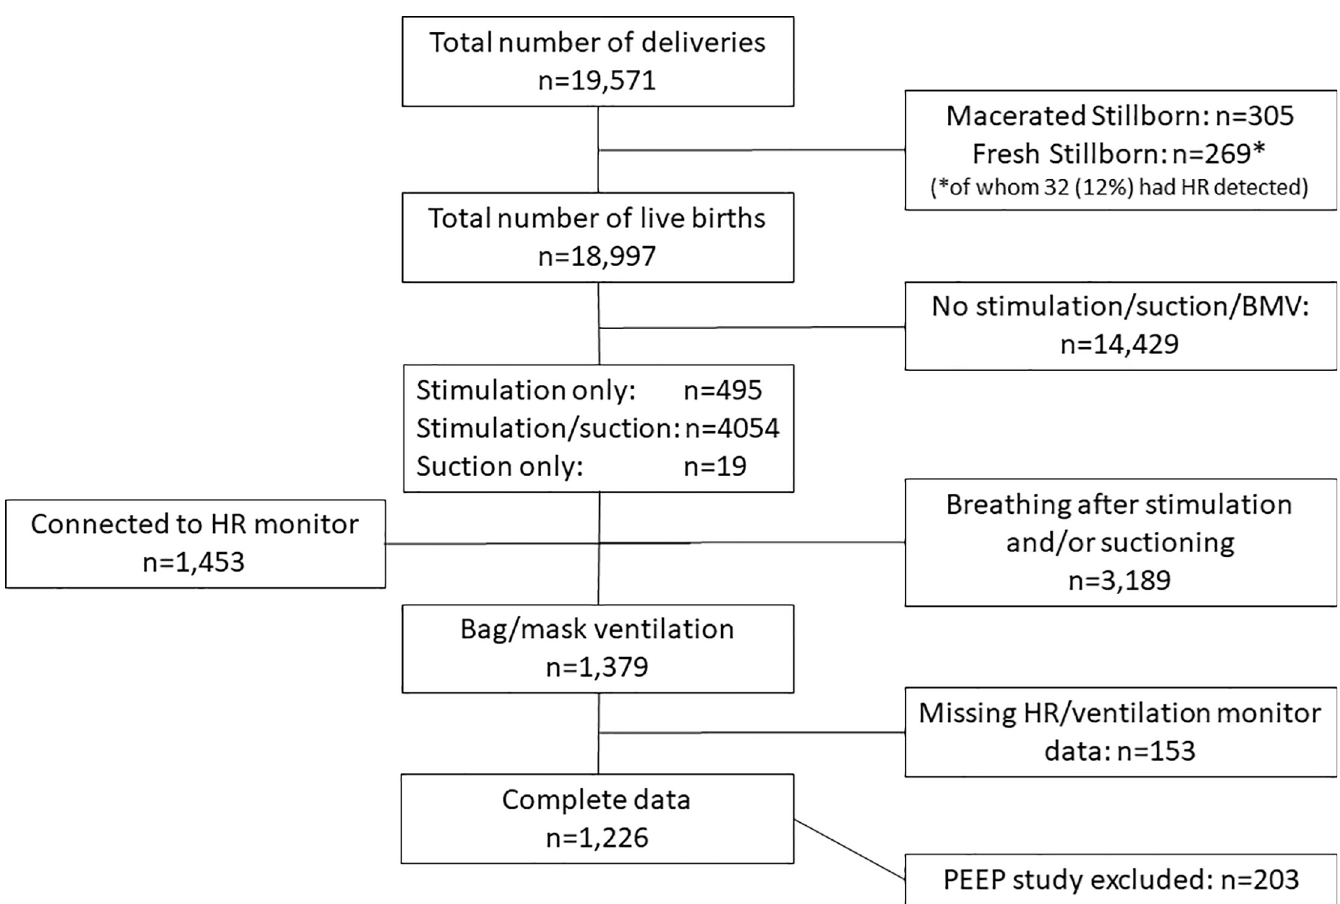
Fig 2. Flow chart of participants in a population-based study of births in Haydom hospital during 1.7.2013 to 30.6.2018.